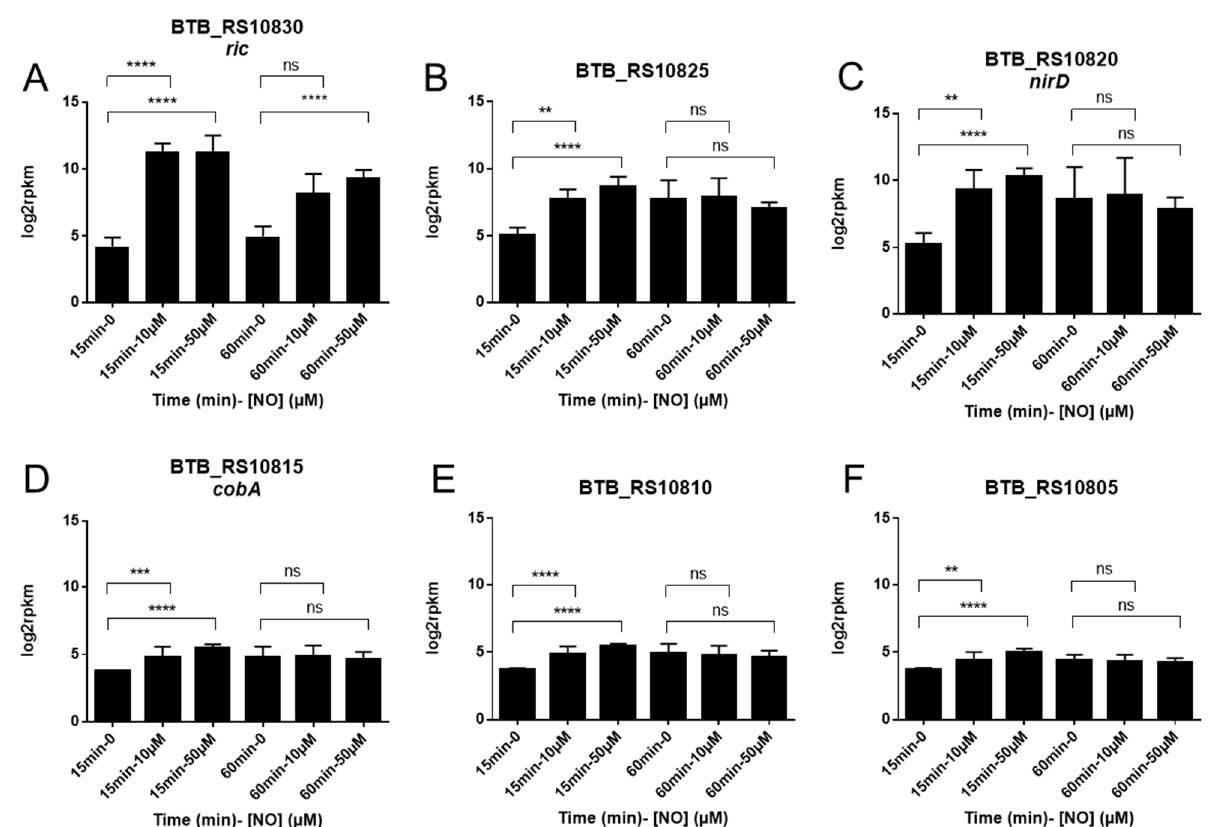
Figure 3. Expression of the 6 genes of the BTB_RS10830-BTB_RS10805 region as measured by RNAseq across time points and levels of NO stress. Gene expression level is counted in reads per kilobase of transcript, per million of mapped reads (represented here in log2-scale). Average and standard deviation from three independent experiments are shown. (Mann-Whitney, ns, not significant, q-value ** <0.01 *** <0.001, **** <0.0001); ( A ) BTB_RS10830 encoding RIC; ( B ) BTB_RS10825 encoding the large sub unit of the nitrite reductase; ( C ) BTB_RS10820, encoding the small sub unit of the nitrite reductase (NirD); ( D ) BTB_RS10815, encoding the uroporphyrin-III C-methyltransferase; ( E ) BTB_RS10810, encoding the sirohydrochlorin chelatase; ( F ) BTB_RS10805, encoding the precorrin-2 dehydrogenase.